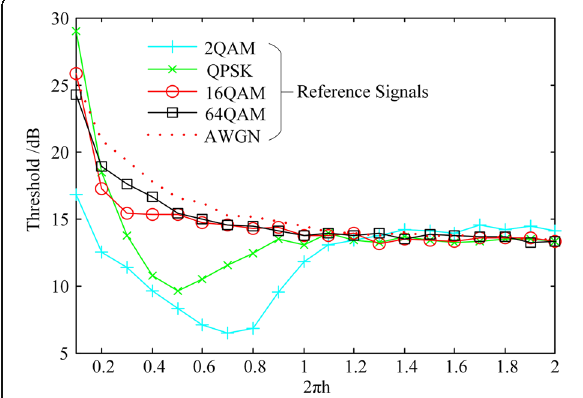
Fig. 11 The detection threshold of CE-OFDM RadCom system for different MQAM and 2 π h. Detailed legend: the lines with the plus sign, cross, circle, and square represent 2QAM, QPSK, 16QAM, and 64QAM being used to produce reference signals, respectively. The dotted line represents the AWGN used for producing reference sig- nals. In Fig. 11, the threshold value means the setting threshold for 0.001 false alarm probability and 0 dB